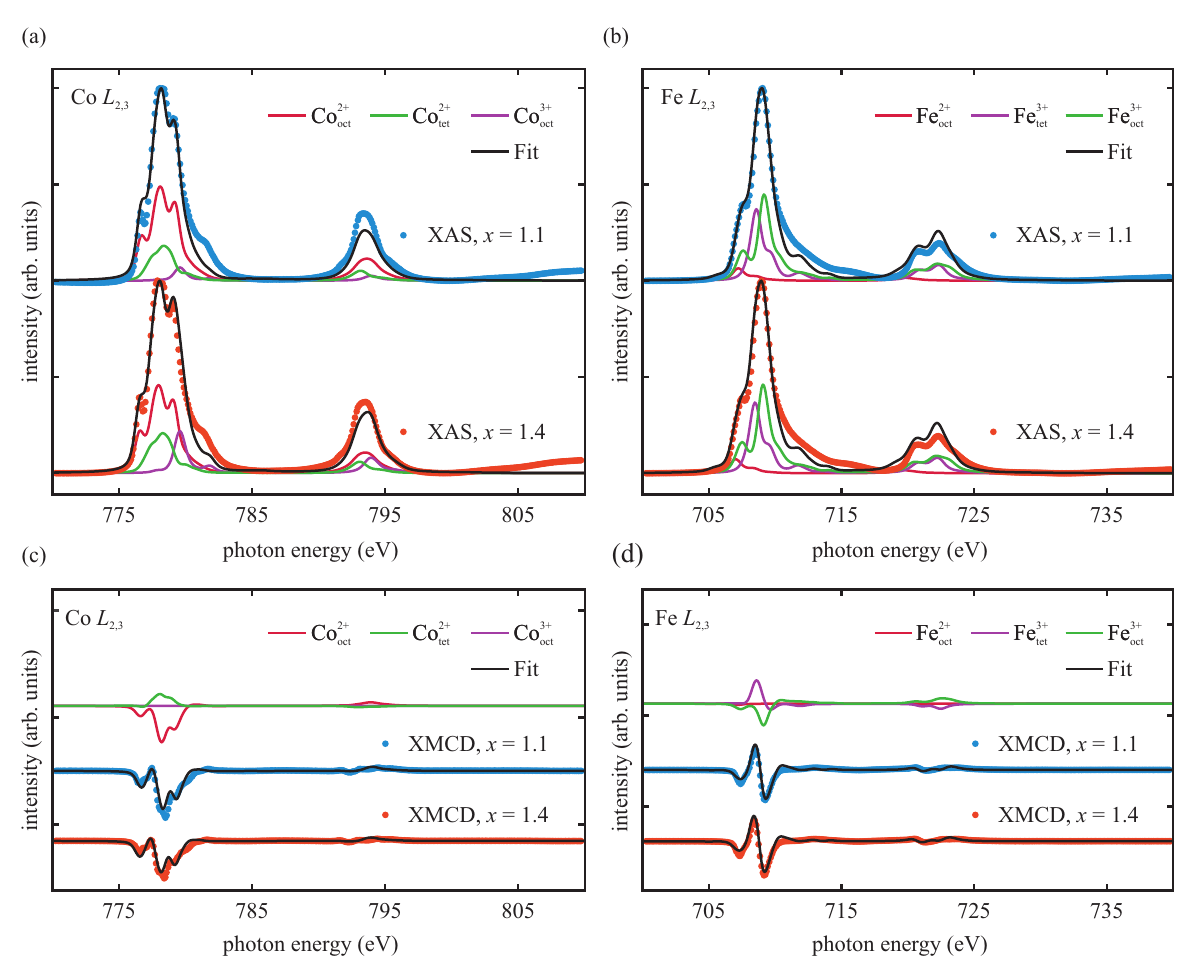
Figure 6. XA and XMCD spectra of the Co L 2,3 and Fe L 2,3 edges with their corresponding CTM calculations (black lines) for each sample. The XA and XMCD spectra at the Co L 2,3 edge in ( a , c ), respectively, were fitted with superpositions of octahedral coordinated Co 2 + and Co 3 + cations and tetrahedral coordinated Co 2 + cations. For the XA and XMCD spectra at the Fe L 2,3 edge in ( b , d ), respectively, superpositions of octahedral coordinated Fe 2 + and Fe 3 + cations and tetrahedral coordinated Fe 3 + cations were used. The individual cationic contributions to the total CTM spectra are shown for each XA spectrum and each sample. For the XMCD spectra, only the individual cationic contributions of the Co 1.1 Fe 1.9 O 4 film are depicted for clarity, serving as a representative for the Co 1.4 Fe 1.6 O 4